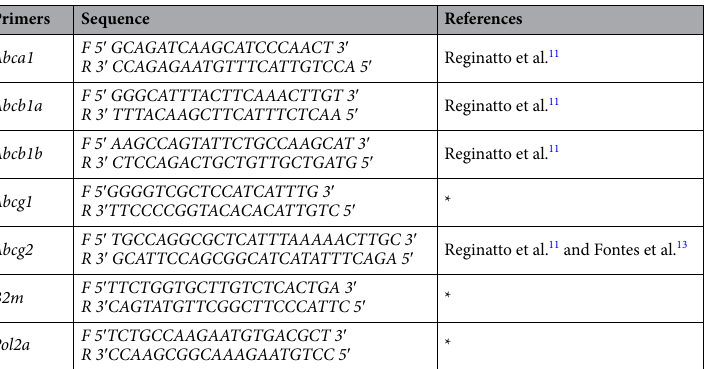
Table 1. Primers used in the present study. *Gene specific primers were designed with primer-BLAST (http:// www. ncbi. nlm. gov/ tools/ primer-